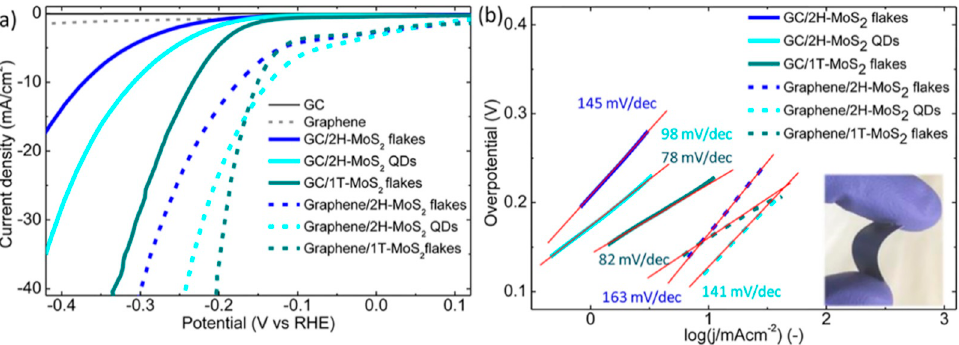
Figure 14. ( a ) Polarization curves of 2H-MoS 2 flakes, 2H-MoS 2 QDs, and 1T-MoS 2 flakes on glassy carbon electrode (solid lines) and graphene/2H-MoS 2 flakes, graphene/2H-MoS 2 QDs and graphene 1T-MoS 2 flakes (dashed lines). Polarization curves of glassy carbon and graphene flakes are also shown for comparison. ( b ) Tafel plots of the same MoS 2 -based electrodes are shown in panel ( a ). Linear fits (red lines) and the corresponding Tafel slop values are reported. Inset: photograph of a representative flexible hybrid graphene flakes/2H-MoS 2 QD electrode. Reproduced with permission from [90]. American Chemical Society, 2017.